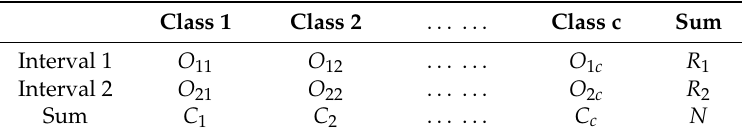
Table 1. The contingency table of Chi-square